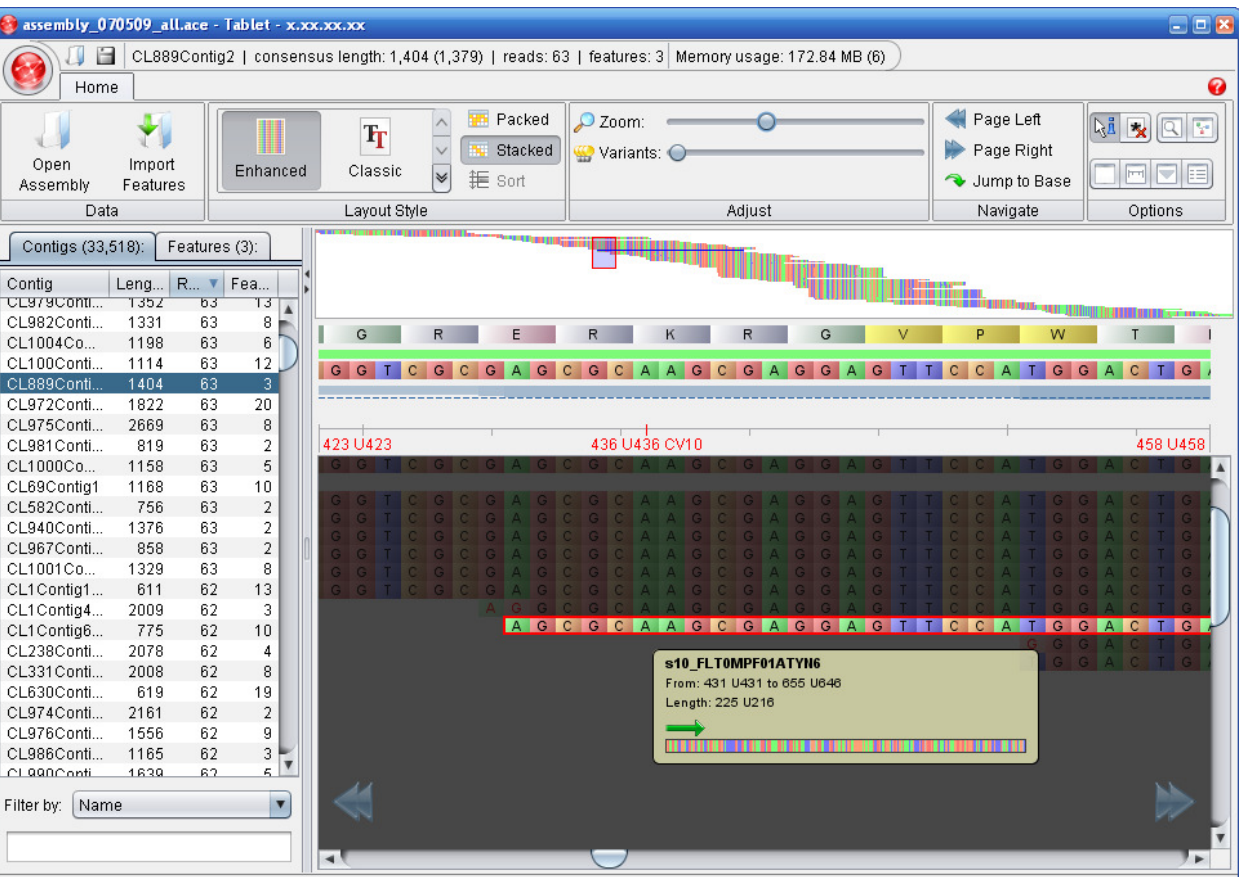
Figure 1. A screenshot of Tablet, an Alignment / Assembly visualization software. Figure taken from